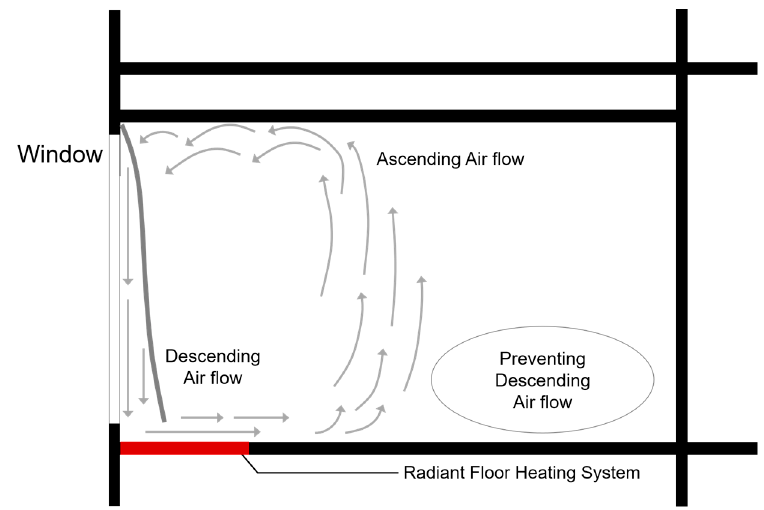
Figure 1. Airflow by application of radiant floor heating systems (RFHS) (narrow area/high surface temperature).